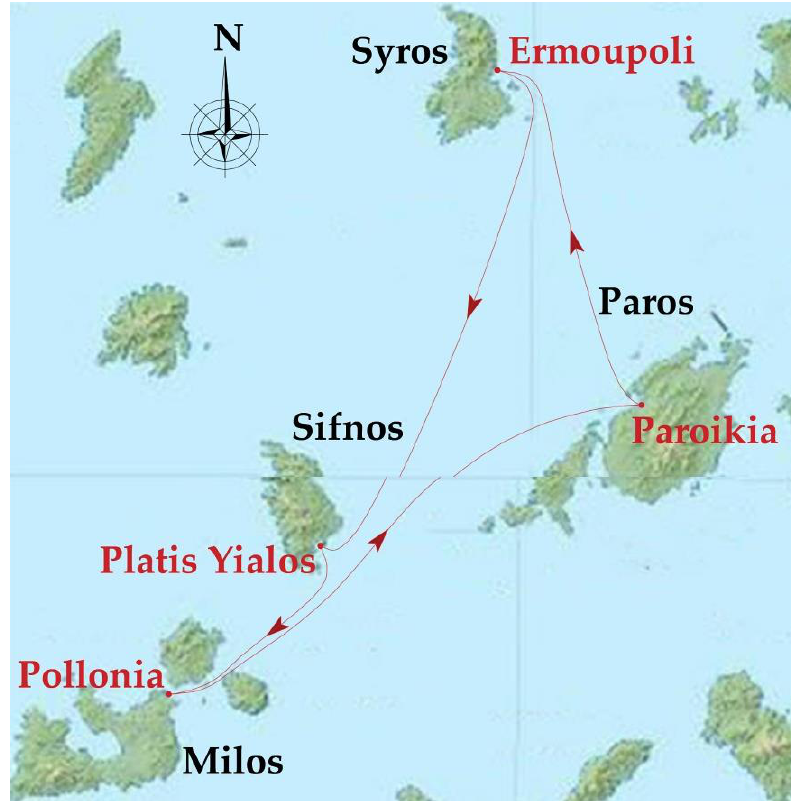
Figure 16. Map of the potential circular ship voyage for the daily maritime connection between Sifnos and the neighboring islands.